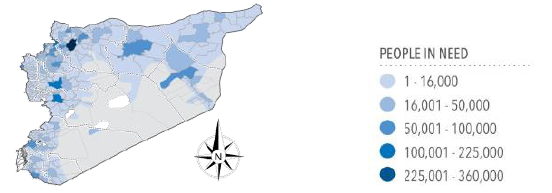
Figure 1. Distribution of people in need of shelter in Syria (UN,